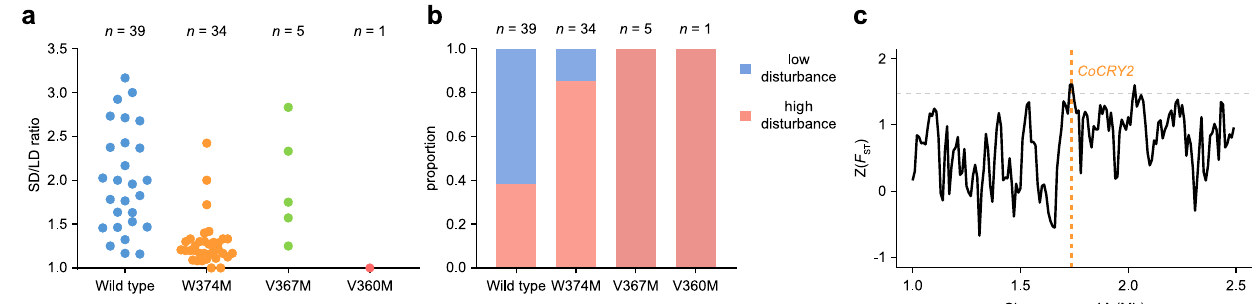
Fig. 5 | CRY2 W374M contributes to the adaptation of pop3 to high-disturbance environments. a Dominant mutations in CRY2 contribute to early- fl owering in SD. TheSD/LDratiowascalculatedbydividingthemediannumberoftotalleaveswhen plants started to bolt in SD by the median number of total leaves when plants startedtoboltinLD.The79 C.occulta accessionsaregroupedby CRY2 haplotypes. Each dot represents an accession. b The proportion of the C. occulta accessions